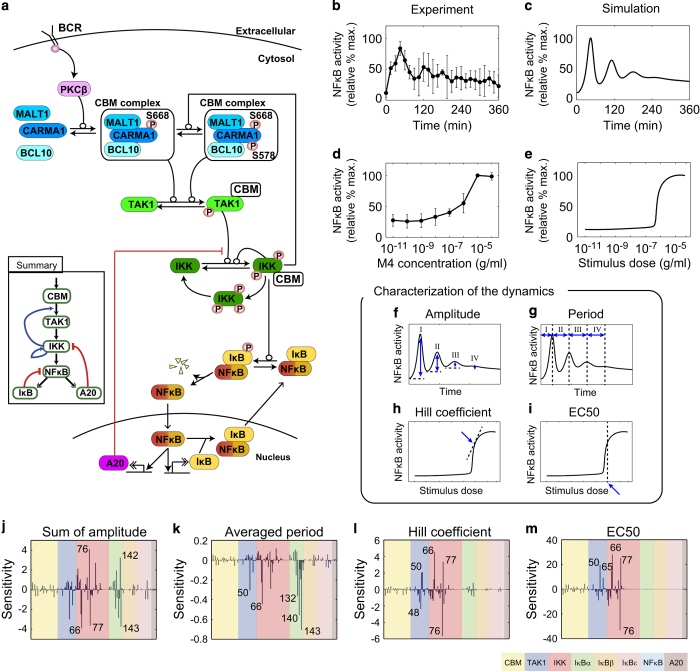
Network structure and sensitivity analysis of nuclear factor kappa B (NF-κB) dynamics. (a) Diagram of the BCR-NF-κB signaling network. (b–e) For NF-κB activity, chicken DT40 B cells were stimulated with anti-IgM mAb (M4) and nuclear NF-κB was assessed by western blotting (Supplementary Figures 3 and 4). (b and c) Time-course profiles of NF-κB activation after stimulation (M4 concentration; 10−5 g/ml). (d and e) Dose response dynamics of NF-κB activation by BCR stimulation at 45 min. (b and d) Experimental results. Error bars denote standard error for six independent experiments. (c and e) Simulation results. (f–i) Schematic description of characterization of the dynamics. (f) Oscillation amplitudes and (g) oscillation period in the time-course analysis. (h) Hill coefficient and (i) EC50 in stimuli dose response analysis. (j–m) Parameter sensitivity for (j) amplitude and (k) period of oscillation, (l) Hill coefficient and (m) EC50 for antigen dose response of NF-κB activity. Colors indicate reaction indices for the CBM complex (yellow), TAK1 phosphorylation (blue), IKK phosphorylation (red), IκBα (green), IκBβ (orange), IκBε (pink), NF-κB (light blue) and A20 (brown). Numbers in j–m indicate the reaction indices in a detailed reaction scheme (Supplementary Figure 1). BCR, B-cell receptor.